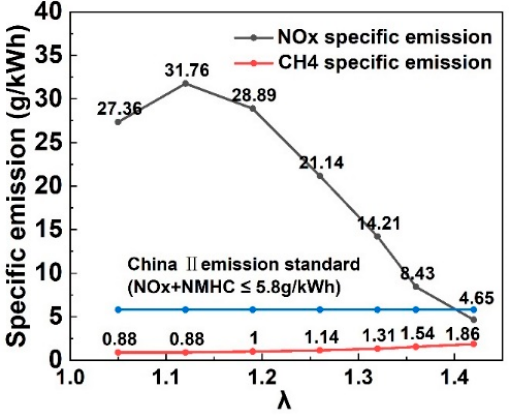
Figure 3. NOx and CH 4 emissions under different λ . Figure 3. Nox and CH 4 emissions under different λ